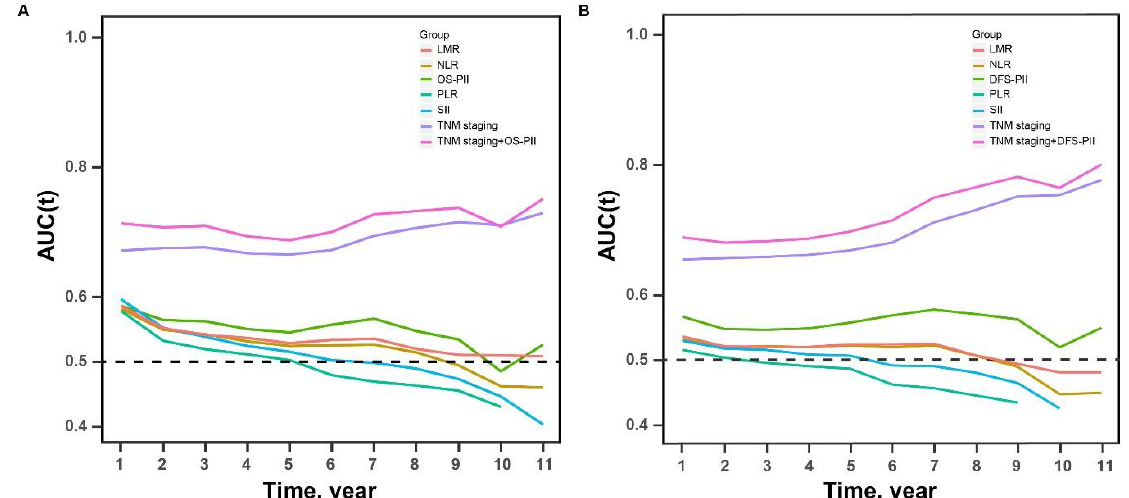
Figure 3. The time-dependent AUCs of PIIs, TNM staging, a combination of PIIs and TNM staging, NLR, PLR, LMR, and SII in the training cohort. Time-dependent AUCs presented the sequential trends of PIIs, TNM staging, a model of PIIs and TNM staging, NLR, PLR, LMR, and SII for overall survival prediction ( A ) and disease-free survival prediction ( B ). The horizontal axis represents the years after radical resection, and the vertical axis represents the estimated area under the ROC curves for survival at the time of interest.